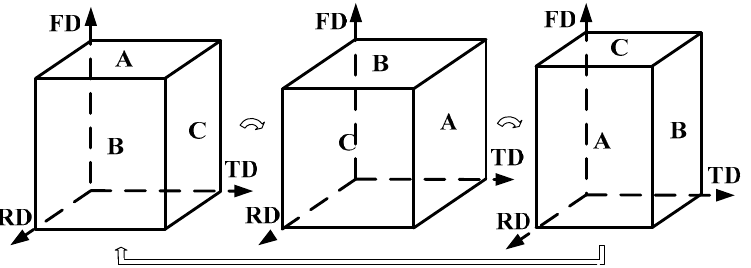
Figure 1. Schematic drawings and axis definition of the high strain rate multiple forging (HSRMF)